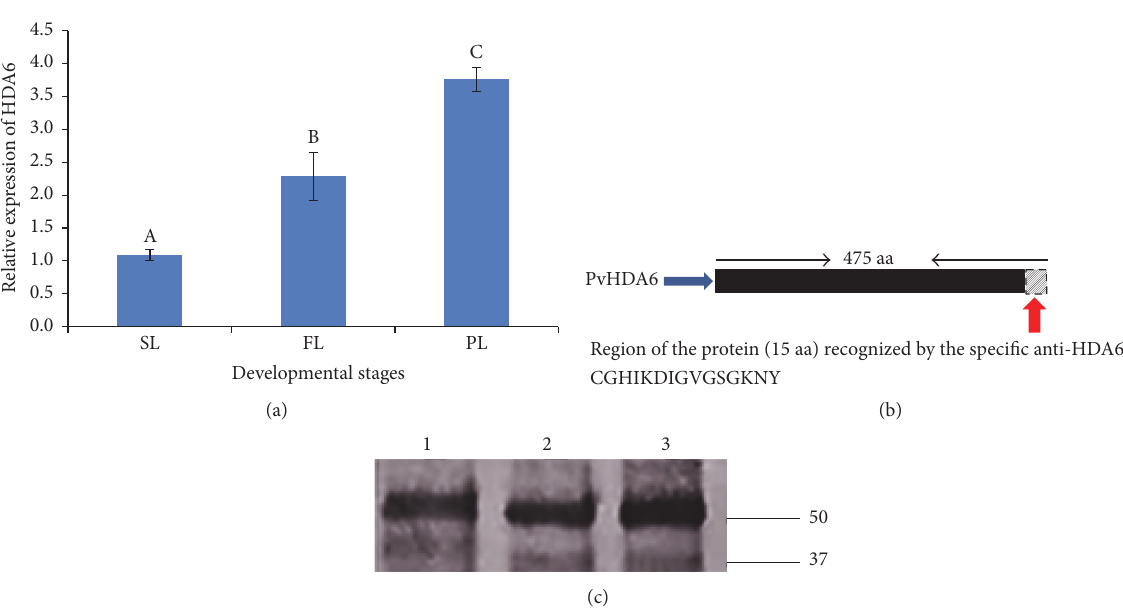
Figure 3: Validation of relative expression level of HDA6 by qPCR using leaf tissues at different developmental stages of common bean. (a) Relative expression of HDA6 gene in leaves at the seedling, flowering, and pod developmental stages of common bean. Three biological and three technical replicates were used for the analysis. The alphabets in the figure show that the expressions of HDA6 in the leaf tissue at the different developmental stages are statistically significant at 𝑝 < 0.05 . (b) Diagram illustrating the common bean specific HDA6 polyclonal antibody raised for protein validation. The 15 amino acids’ peptide indicated in faded lines with red arrow is one of the three peptides selected for the epitope. (c) Western blot analysis using common bean specific HDA6 antibody. The figure further validates the role of HDA6 in common bean development.